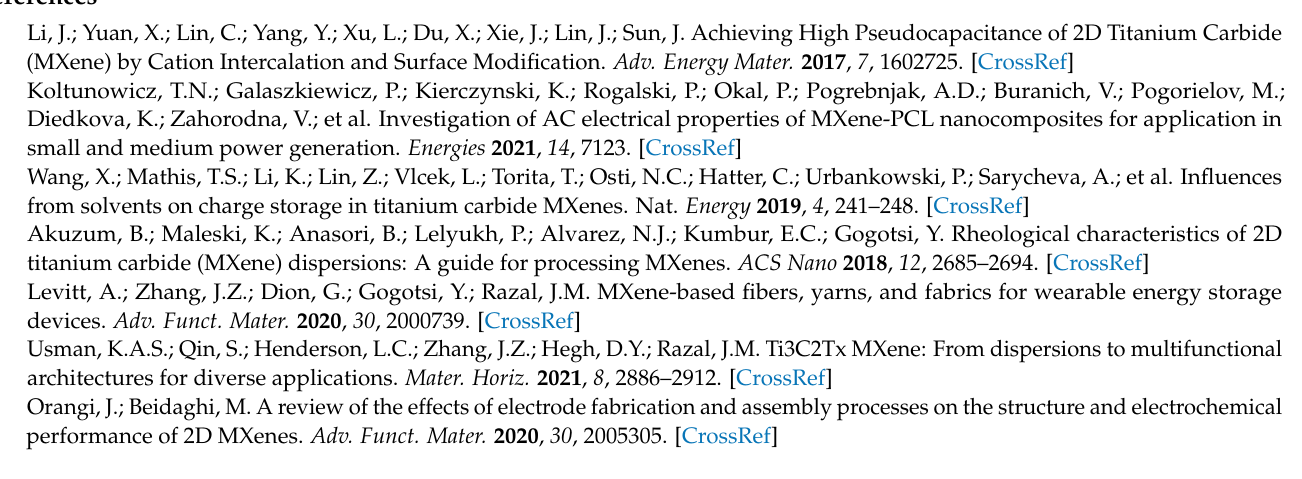
of disordered and aligned Ti 3 C 2 T x aerogel, Figure S4: CV curves at scan rates from 10 to 5000 mV s − 1 for disordered Ti 3 C 2 T x aerogel, Figure S5: GCD profiles of the aligned Ti 3 C 2 T x aerogel at (a) low current densities from 1 to 20 A g − 1 and (b) high current densities from 50 to 250 A g − 1 , Figure S6: fitted values of the resistive elements in the equivalent circuit (inset) for the Nyquist spectra of disordered and aligned Ti 3 C 2 T x aerogel, Figure S7: CV curves of the symmetric aligned Ti 3 C 2 T x aerogel pseudocapacitor with the mass loading of 10 mg cm − 2 measured at different voltages at 10 mV s − 1 , Figure S8: CV curves of aligned Ti 3 C 2 T x aerogel with the mass loading of 0.8 mg cm − 2 measured at different voltages at 10 mV s − 1 in a two-electrode configuration, Figure S9: CV profiles from 10 to 1000 mV s − 1 at (a) 25 ◦ C and (b) − 30 ◦ C, Figure S10: (a) GCD curves of aligned Ti 3 C 2 T x aerogel at different temperatures with a current density of 10 A g − 1 and (b) capacitance retention with operating temperatures from 25 to − 30 ◦ C at different current densities, Figure S11: nyquist plots at different temperatures (scatter represents raw data, and line represents fitting